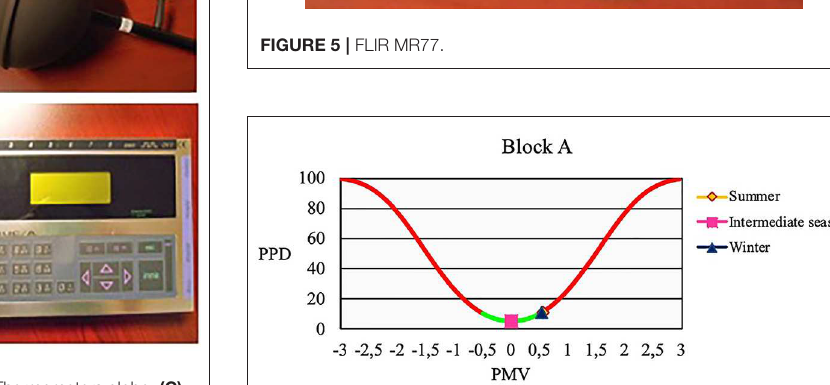
FIGURE 4 | (A) Psychometric wet bulb sensor, (B) Thermometers globe, (C) Hot wire anemometer sensor, (D) 11 inputs multiple data acquisition device- BABUC/A.